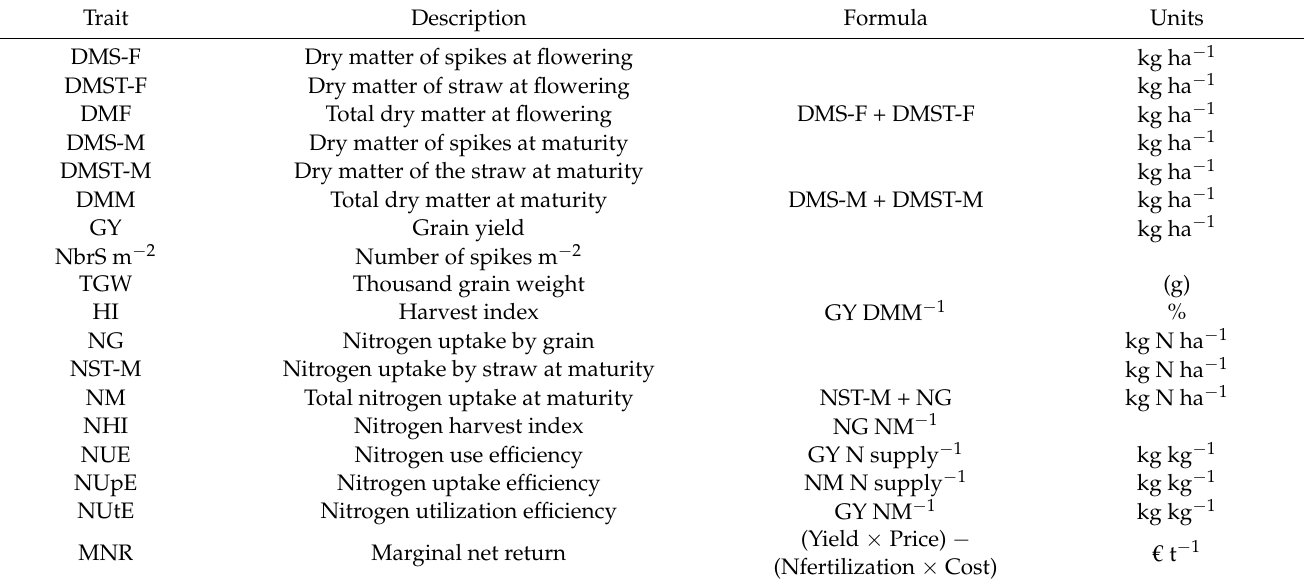
Table 3. Description of measured and calculated